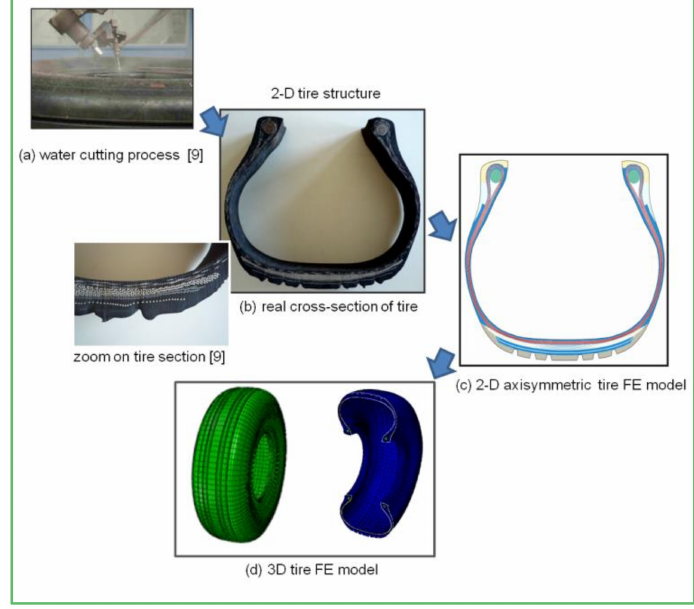
Figure 12. Tire 3-D finite element model built-up from the 2-D tire cross